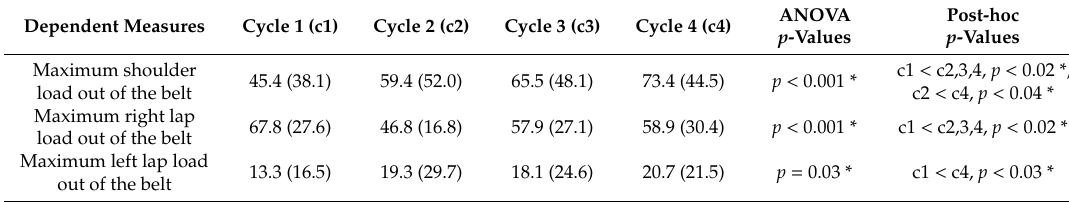
Table 6. Mean (SD) of the maximum seat belt load: e ff ect of cycle.